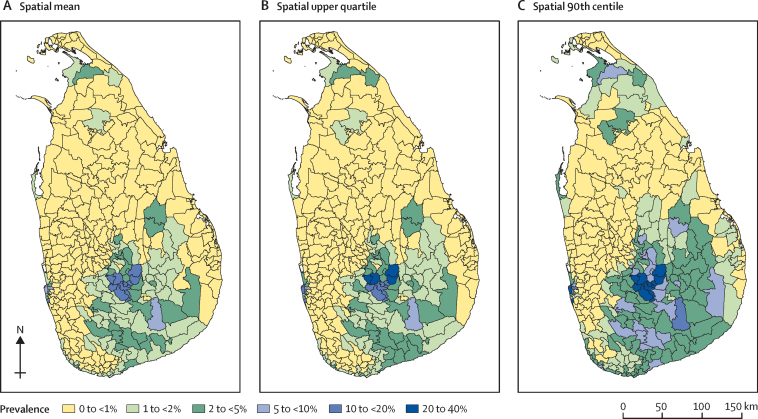
Estimated soil-transmitted helminth prevalence in MOH areas of Sri LankaPrevalence is shown for each MOH area as spatial mean (representing the overall mean in the MOH area; A), spatial upper quartile (B), and spatial 90th centile (C). MOH=Medical Officer of Health.